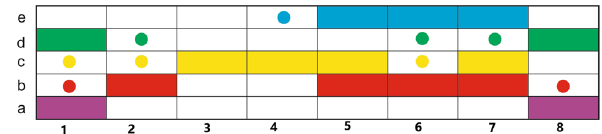
Figure 2: Targowisko settlement region. A graphic model of the sequence of settlement phases of LBK and MC settlements at the sites: ( 1 ) Zagórze 2, ( 2 ) Brzezie 17, ( 3 ) Brzezie 40, ( 4 ) Szarów 9, ( 5 ) Targowisko 16, ( 6 ) Targowisko 14 – 15, ( 7 ) Targowisko 12 – 13 and ( 8 ) Targowisko 10 – 11; ( colored rectangles – stable settlement with house remains; colored rings – settlement without the remains of houses ) ; ( a ) LBK phase I ( Zo fi pole style ) , ( b ) LBK phase II, ( c ) LBK phase III, ( d ) MC phase Ia and ( e ) MC phase Ib ( acc. to Kadrow et al., 2021 )